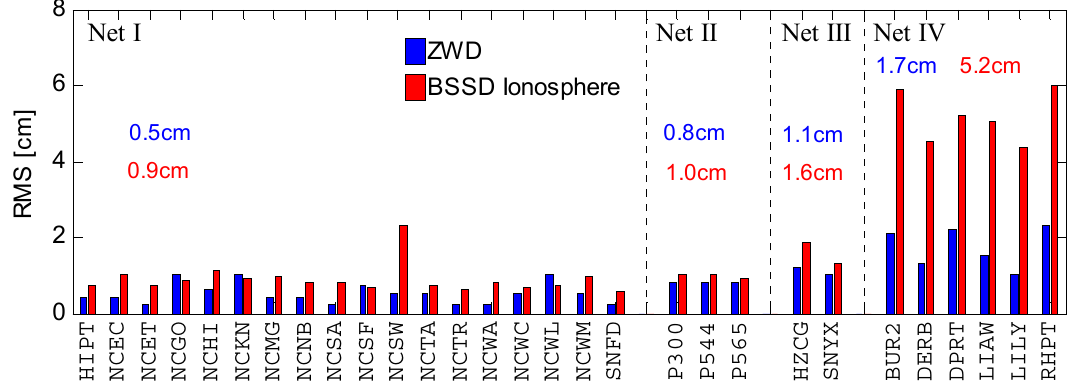
Figure 11. Atmosphere modelling accuracy for all user stations.